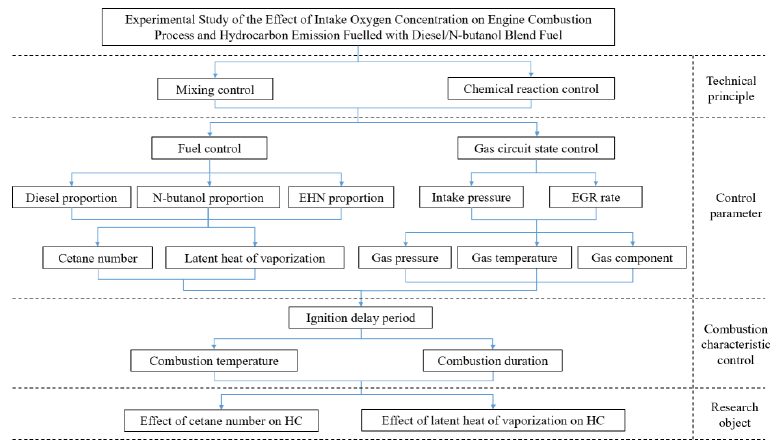
Figure 1. General research approach and